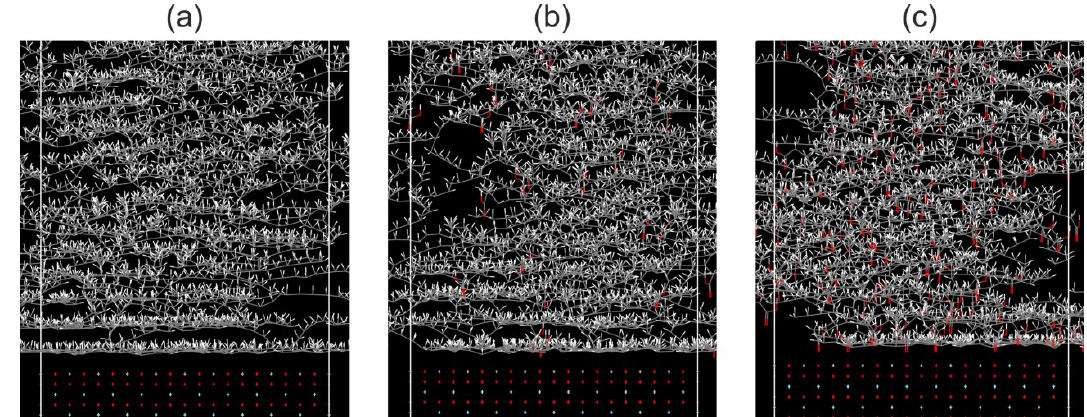
Figure 2. The equilibrium structures of ( a ) polyethylene (PE), ( b ) polyethylene grafted with 5 mol% of acrylic acid (5AAPE), and ( c ) polyethylene grafted with 30 mol% of acrylic acid (30AAPE) on top of a zirconia surface. The colors represent the atoms as follows: O: red, C: grey, H: white, Zr: cyan.